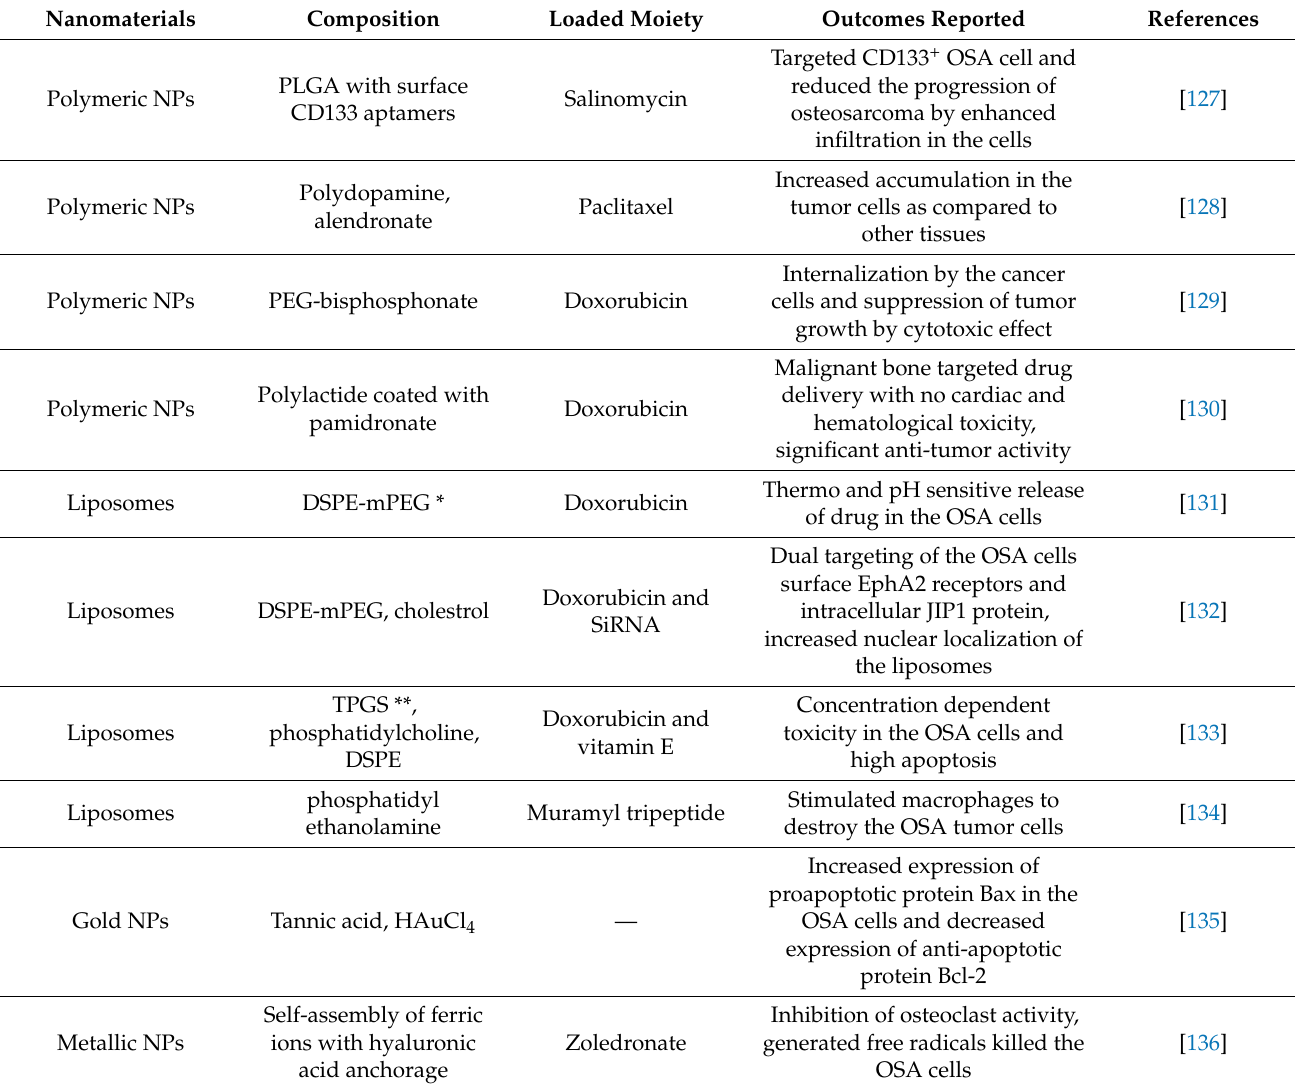
Table 1. Nanoparticulate systems developed for the treatment of